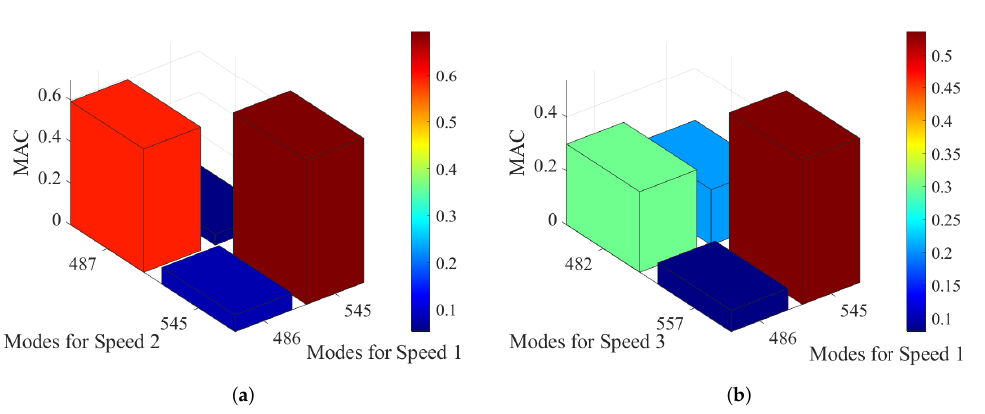
Figure 8. ( a ) MAC between speed 1 of Asb1 and speed 2 of Ref. ( b ) MAC between speed 1 of Asb1 and speed 3 of Ref. MAC matrices comparing the correlation between speeds 2 and 3 for Ref and speed 1 for Asb